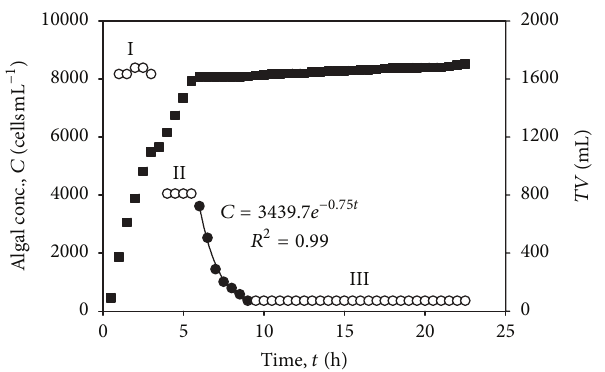
Figure 2: Test of fluorometer controlled apparatus (FCA) without mussels maintaining 3 algal ( Rhodomonas salina ) concentration levels ( 𝐶 , ⃝ ) after initial addition of algal cells to the aquarium ( 𝑉 = 15.4 L) to reach 8, 250 ± 120 cells mL −1 (I) and subsequent two times washout of algal cells with through-flow seawater to reduce the concentration to (II) 4,120 ± 430 and (III) 370 ± 40 cells mL −1 , respectively. The fluorometer controlled addition of R. salina to maintain a constant algal concentration in the aquarium over a certain period of time appears from the total volume (TV) of algal suspension added ( ◼ ). Between 6 and 9 h a constant through- flow of bio-filtered seawater (200mLmin −1 ), which is a measure of “filtration rate,” caused an exponential decrease in the algal concentration ( ∙